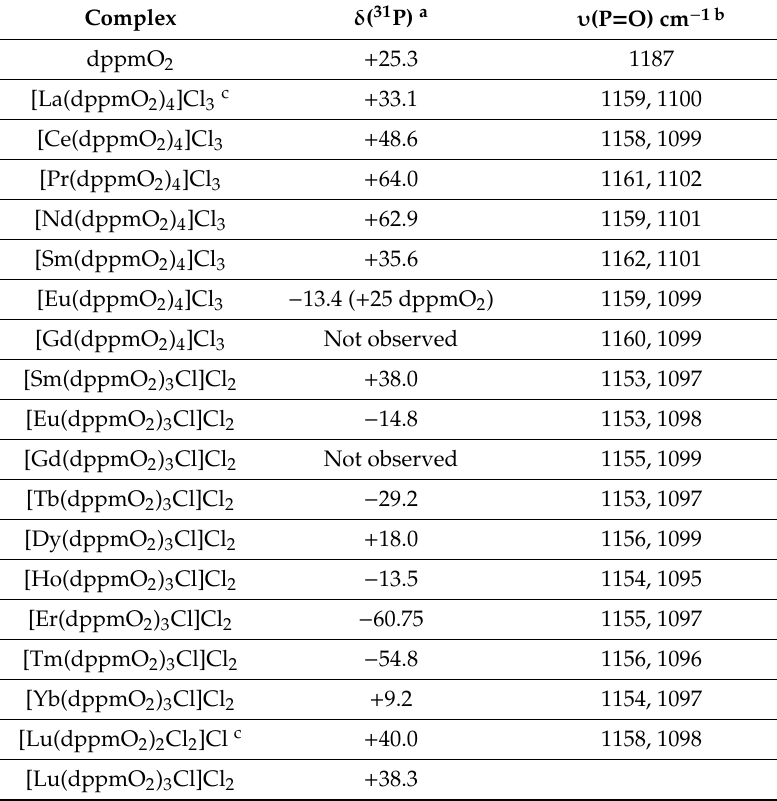
Table 2. IR and 31 P{ 1 H}-NMR spectroscopic